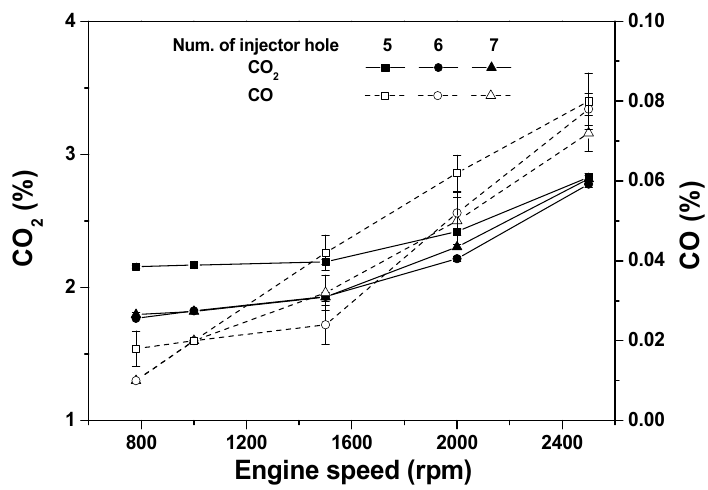
Figure 4. CO 2 and CO emissions with respect to number of injector holes and engine speed.